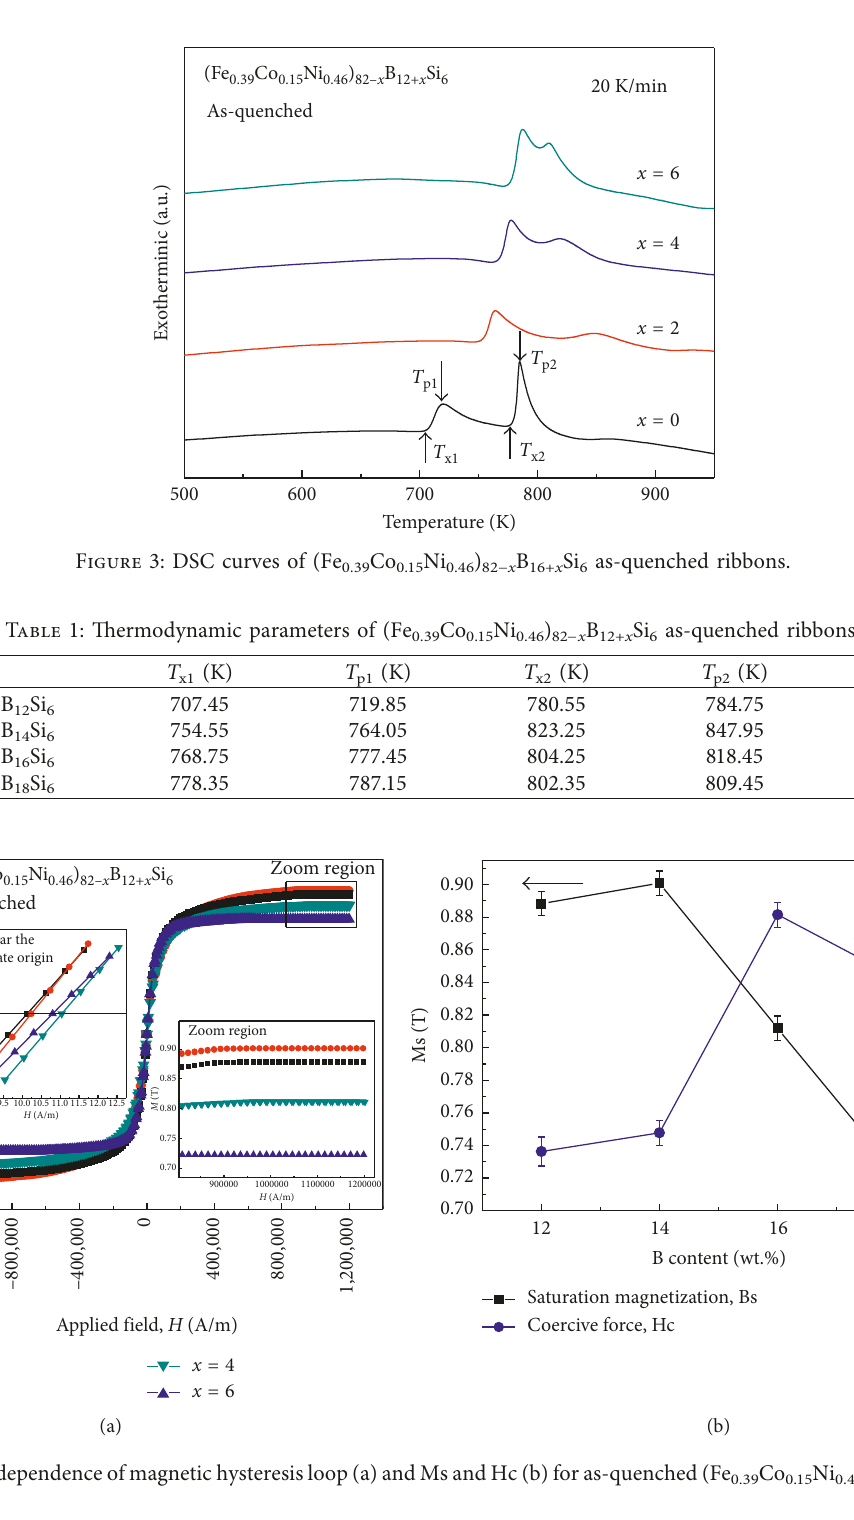
0.39 Co 0.15 Ni 0.46 ) 82 x B 12+ x Si 6 ( x (cid:31) 0, 2, −